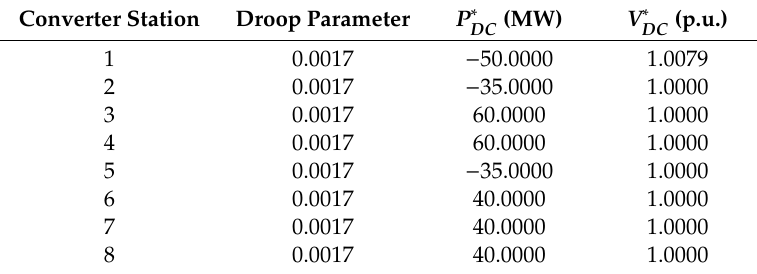
Table A39. Droop control settings for each converter